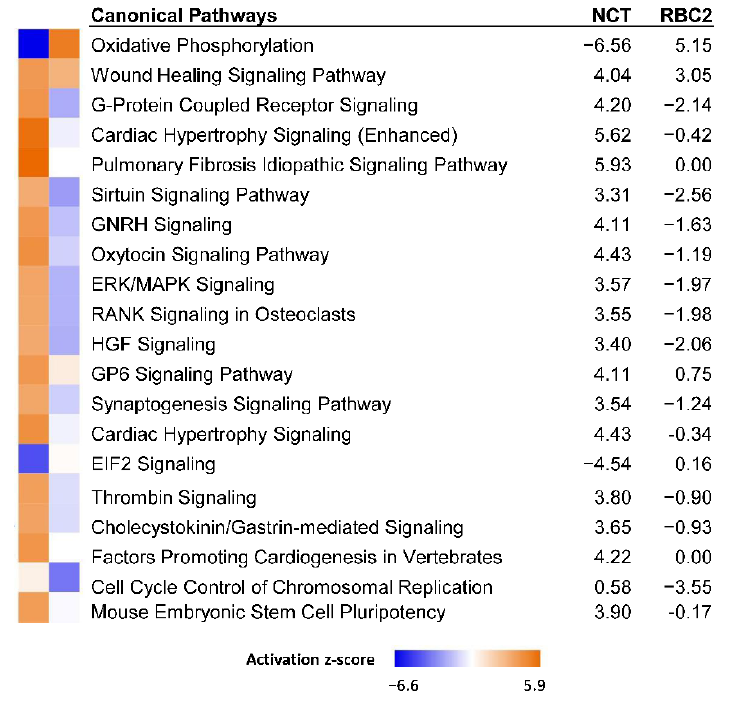
Figure 6. Significant canonical pathways identified in IPA Comparison analysis of genes expressed in NCT versus RBC2 turkey skeletal muscle SCs at 43 °C. Only the 20 pathways with highest composite |z|-scores are shown.